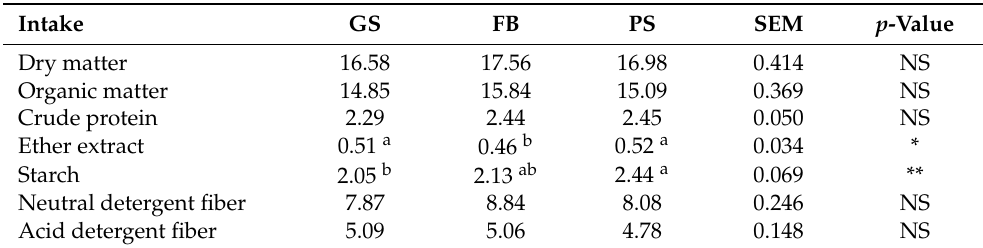
Table 6. Nutrient intake (kg/day, dry matter basis) by dairy cows’ feeding diets based on grass silage (GS), faba bean silage (FB), or field pea silage